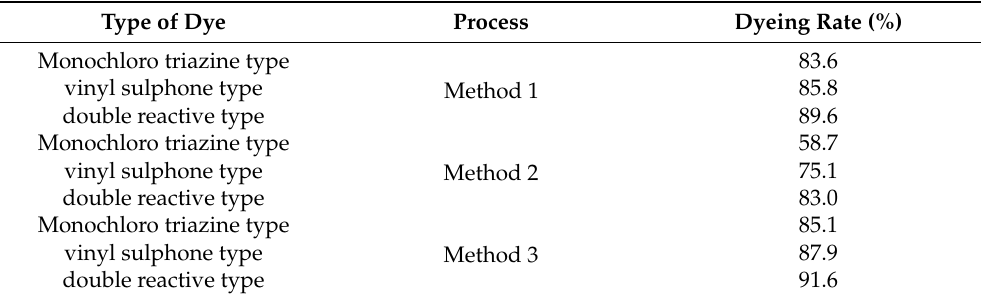
Figure 5. Wrinkle resistance of dyed fabrics. Table 7. Dye uptake of different types of dyes in different dyeing and finishing